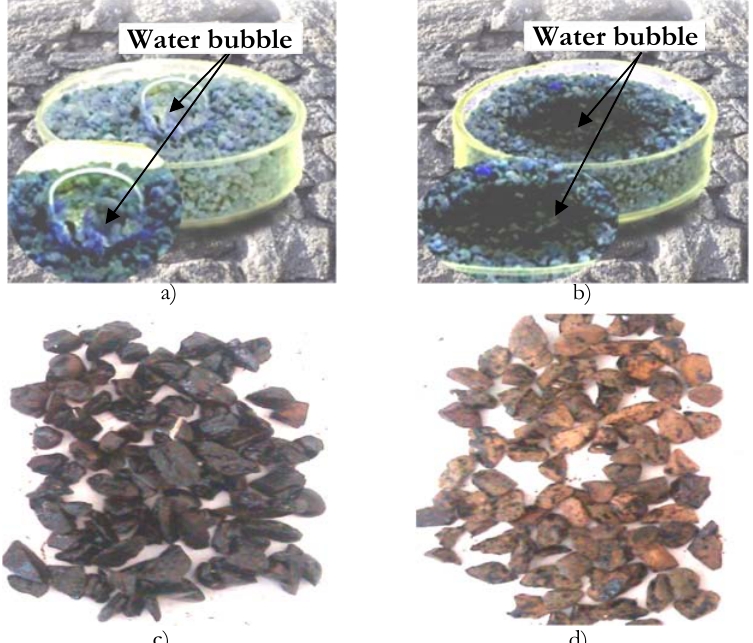
Figure 7: a) Hydrophobicity of the aggregates modified with nano-Zycosil; b) Hydrophilic in the unmodified aggregates; c) Amount of stripping in the modified aggregates (with grading according to Tab. 2); d) Amount of stripping in the unmodified aggregates (with grading according to Tab.